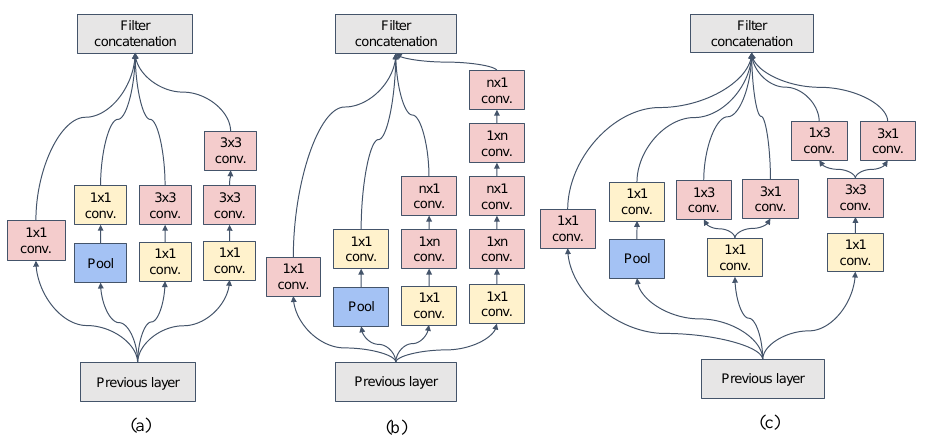
Figure 1. The inception module of Inception v3. ( a ) is the first type of inception module, whose input size is 35 × 35 × 288. ( b ) is the second type of inception module, which splits n × n convolution into n × 1 convolution and 1 × n convolution. ( c ) is the third type of inception module with expanded filter bank